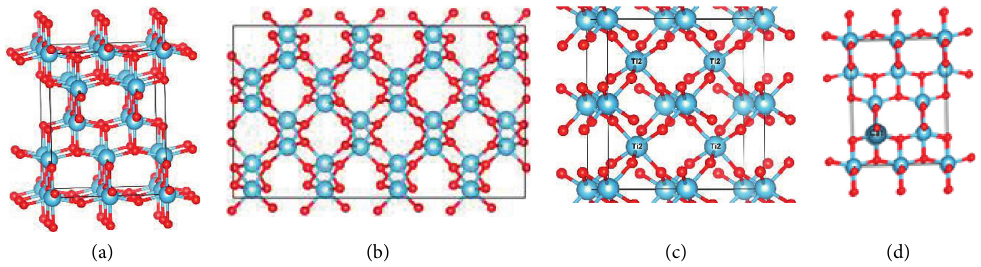
Figure 4: 2 × 2 × 1 supercells of (a) 48-atom anatase, (b) 96-atom brookite, and (c) 24-atom rutile. (d) Single cationic substitution at Ti site in anatase supercell. Ti atoms are represented by light blue circles, and O atoms are represented by red circles.